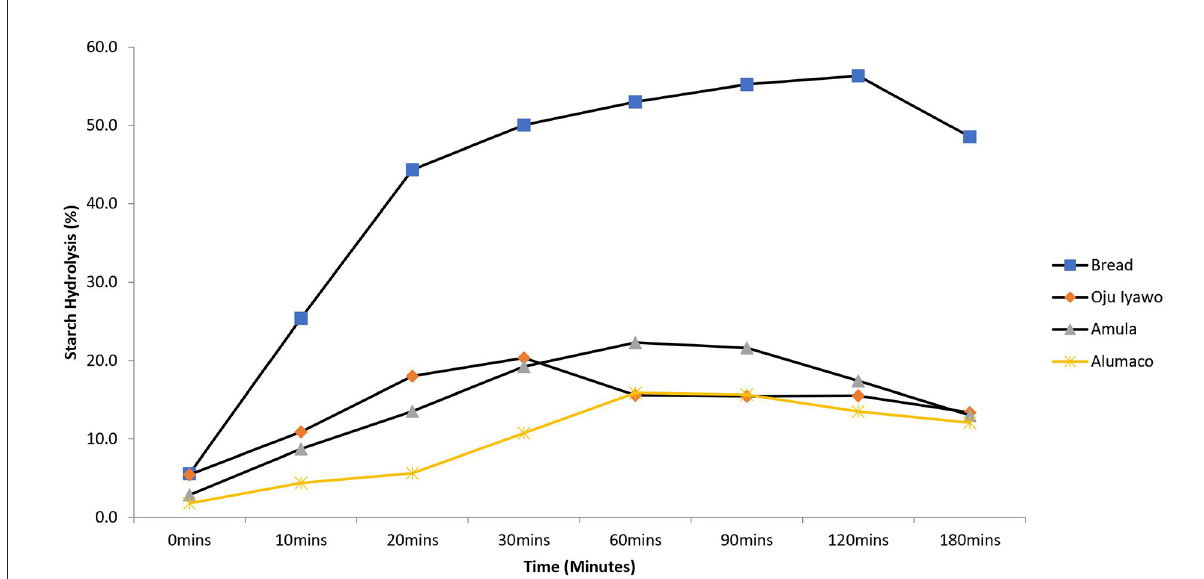
FIGURE3 Rate of in-vitro Starch Hydrolysis in Amala made from three varieties of Yam.